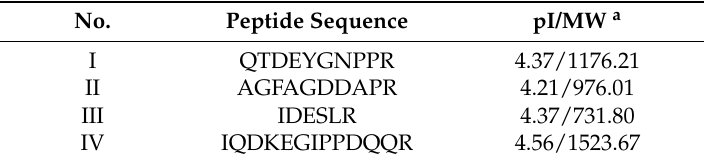
Table 2. Peptides <1 kDa obtained from Lapsang souchon.